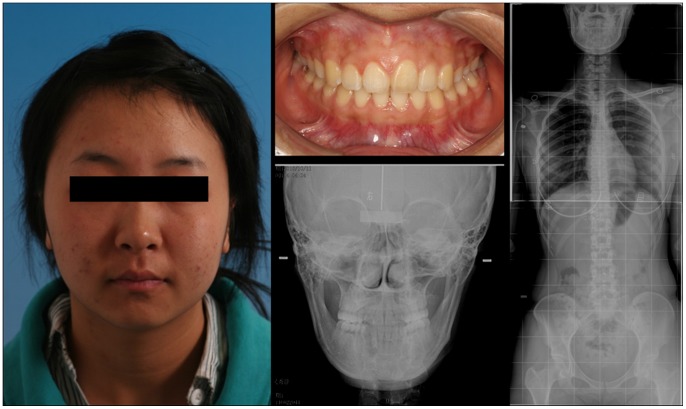
Image from a typical volunteer.